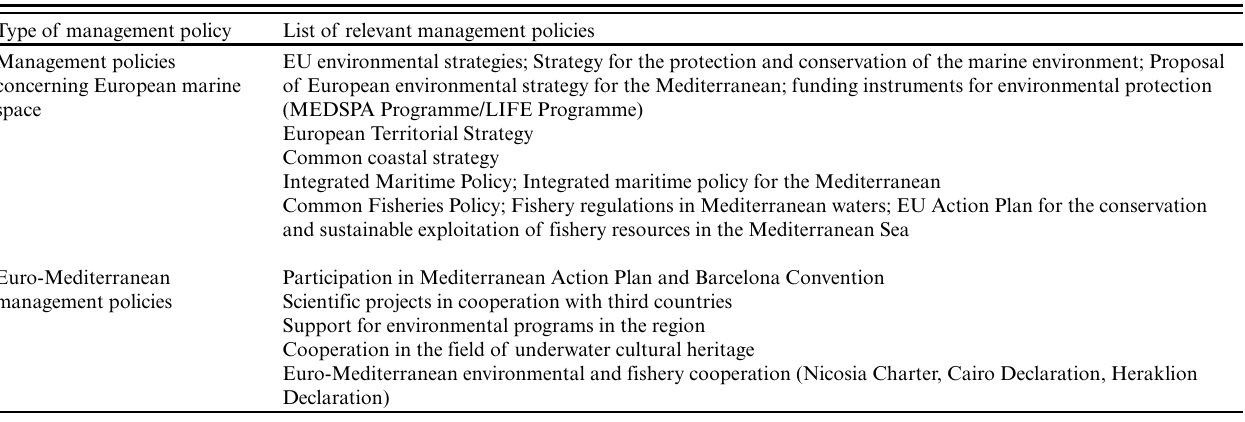
Table 1. European participation in Mediterranean marine